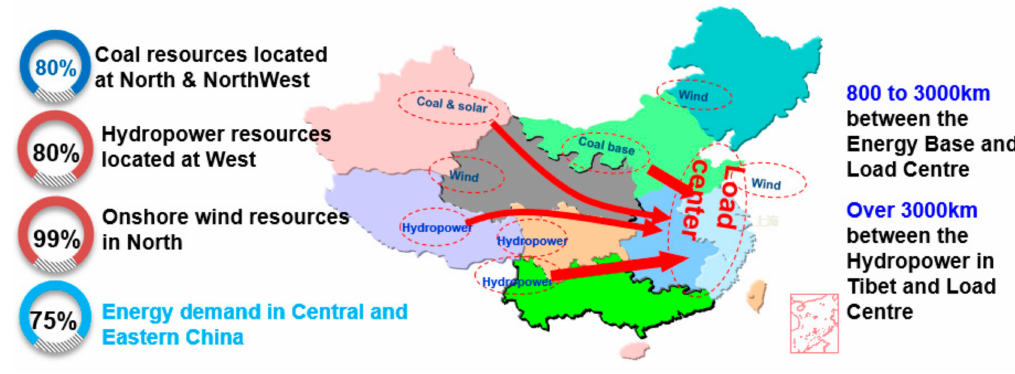
Figure 1. Primary energy and load distribution in